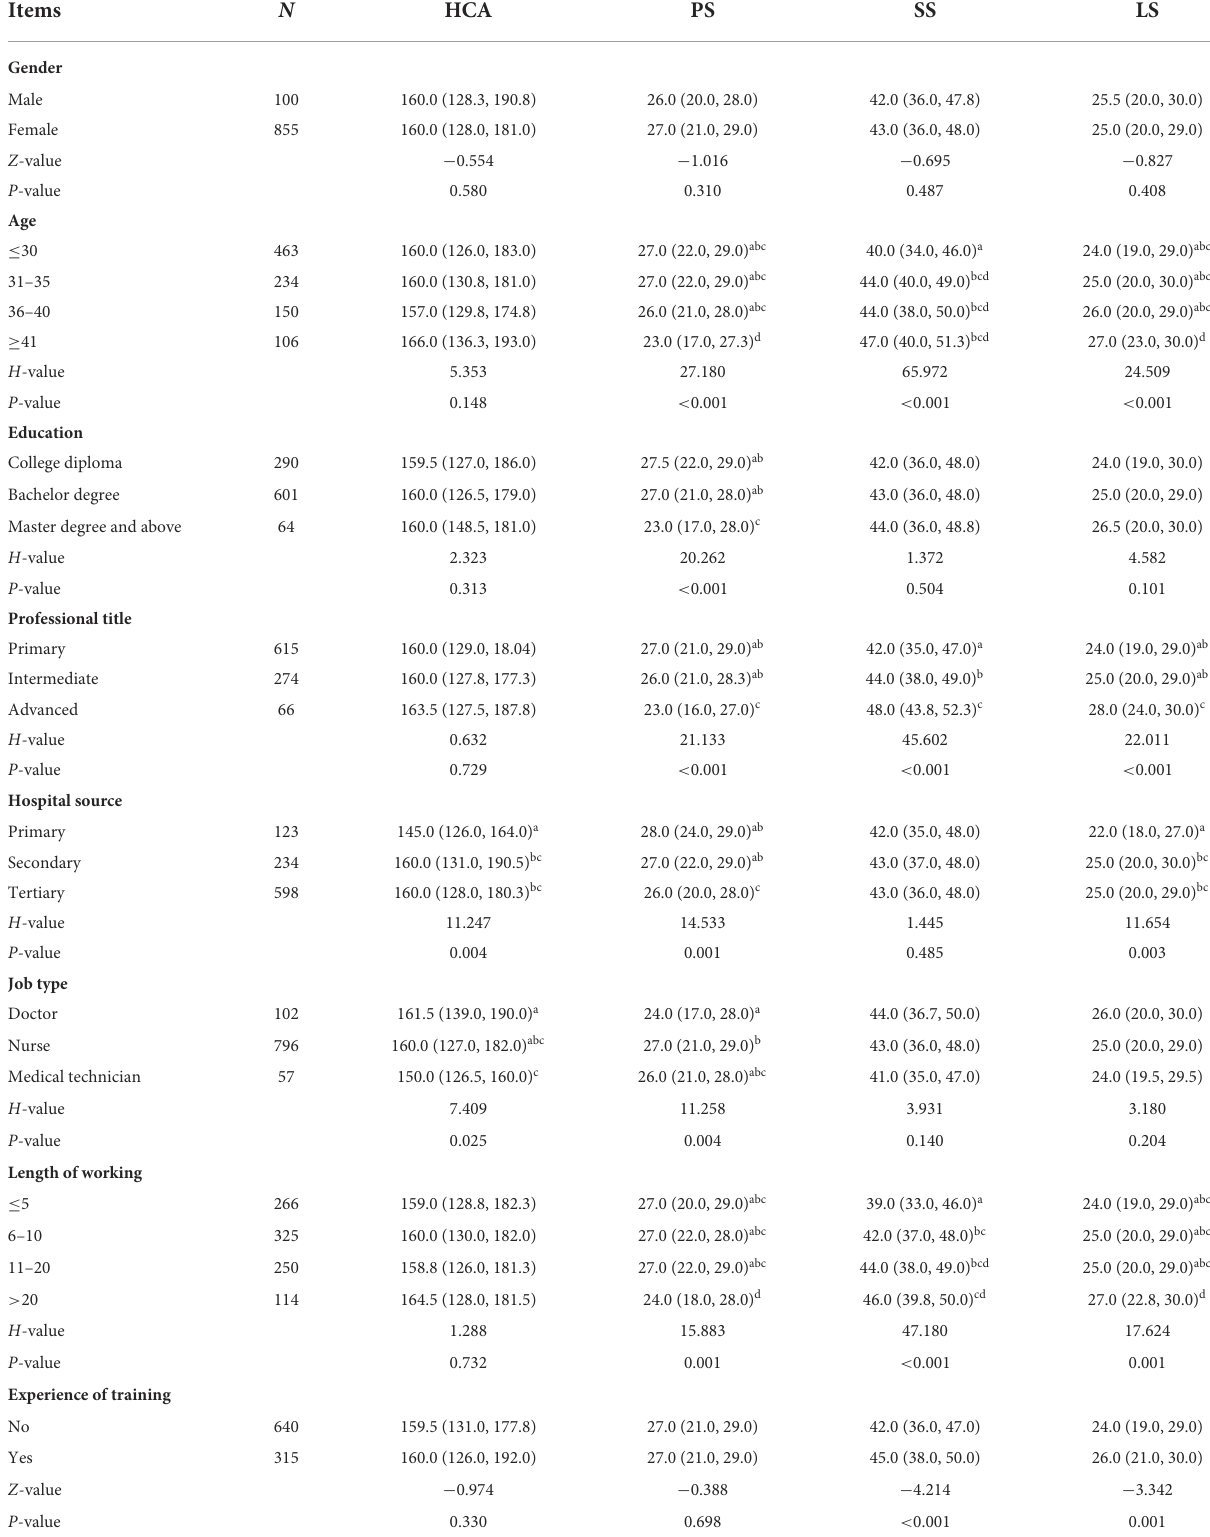
TABLE 1 Comparisons on all scales’ scores by different demographic